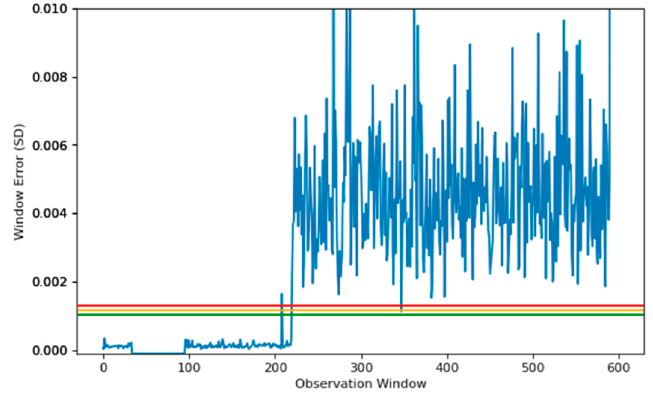
Figure 10. Reconstruction plot using SAE model, using a data window of 1000, on known fault data. The lines denote the threshold based upon the healthy data used to train the model. The same level of thresholds was used in this model.